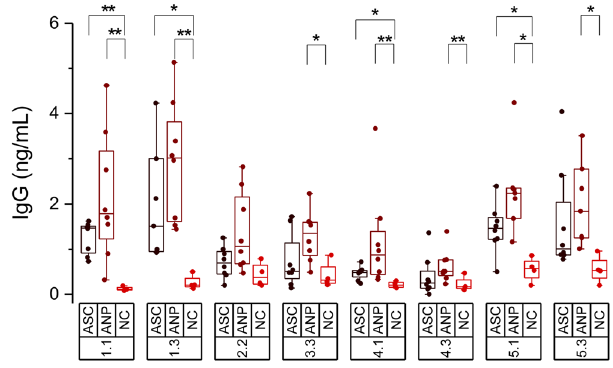
Figure 3. IgG reactivity of adult serum samples from the endemic malaria region with eight selected 20-mer epitopes. Data shows specific IgG concentration present in sera against 20-mer peptides sequences of START (1.1, 1.3); HSP70-2 (2.2); putative protein kinase Uniprot Q8I2Q0 (3.3); HSP60 (4.1, 4.3); and PDI8 (5.1, 5.3). Three different sera groups were used: asymptomatic subclinical (ASC, n = 8), undetected malaria parasite (ANP, n = 8) and no malaria exposed controls (NC, n = 4). The 16 sera used from endemic malaria region were selected from the patients indicated with an asterisk in Table S2. Mean values are given by horizontal lines; boxes depict 25/75 percentiles and whiskers cover data excluding outliers at 1.5 coefficient. Mann-Whitney nonparametric tests were run: * P < 0.05; ** P < 0.01.